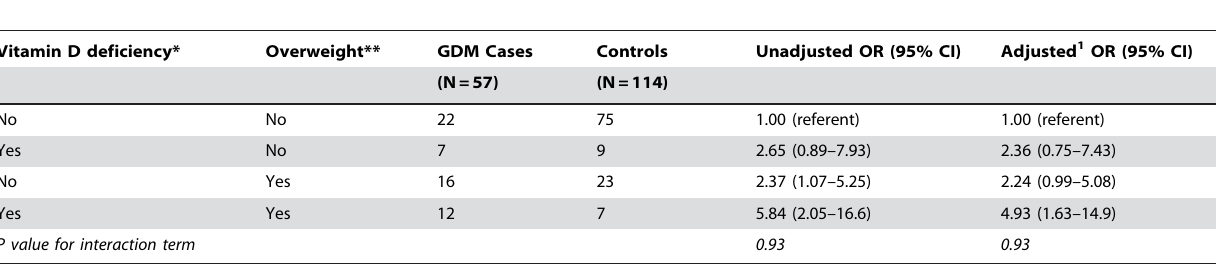
Table 3. Odds ratios (OR) and 95% confidence intervals (CI) for gestational diabetes (GDM) according to both maternal plasma 25- Hydroxyvitamin D deficient status and pre-pregnancy overweight